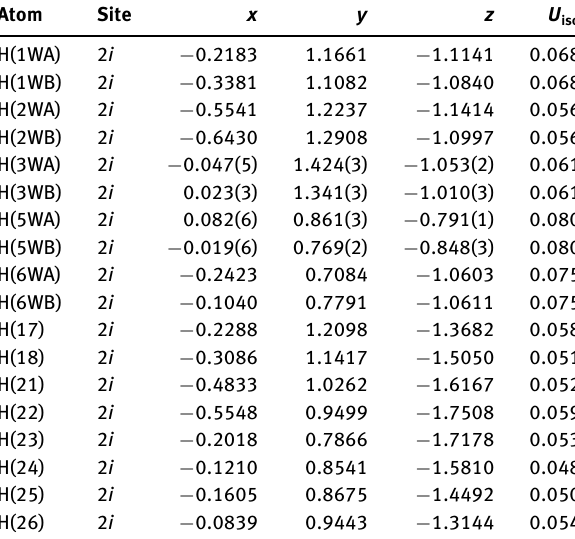
Table 2: Fractional atomic coordinates and isotropic or equivalent isotropic displacement parameters (Å 2